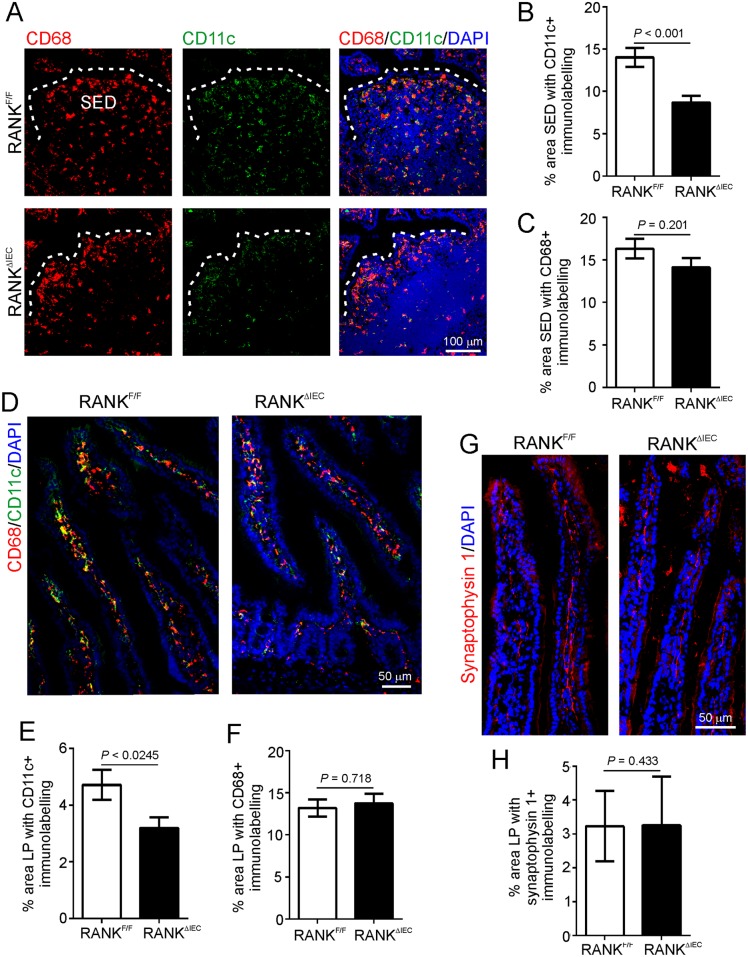
Effect of intestinal epithelial cell-specific RANK-deficiency on mononuclear phagocytes and innervation in the lamina propria.A) Immunohistochemical (IHC) comparison of the distribution of CD11c+ (green) and CD68+ (red) mononuclear phagocytes (indicative of classical DC and tissue macrophages, respectively) in Peyer’s patches from RANKF/F and RANKΔIEC mice. Sections were counterstained with DAPI (blue) to detect cell nuclei. Broken line shows the lumenal boundary of the follicle associated epithelium. SED, subepithelial dome. Morphometric analysis revealed that (B) the % area of the SED occupied by CD11c+ immunostaining was significantly reduced in RANKΔIEC mice (P < 0.001, Mann-Whitney U test), whereas (C) the % area occupied by CD68+ immunostaining was similar between each mouse group (P = 0.201, Student’s t-test; data derived from 1–10 SED/mouse, n = 6–7 mice/group). D) IHC comparison of the distribution of CD11c+ (green) and CD68+ (red) mononuclear phagocytes in the lamina propria (LP) of RANKF/F and RANKΔIEC mice. Sections were counterstained with DAPI (blue). Morphometric analysis revealed that (E) the % area of the CD11c+ immunostaining was also significantly reduced in the LP of RANKΔIEC mice (P < 0.025, Mann-Whitney U test), whereas (F) the % area of CD68+ immunostaining was similar (P = 0.718, Student’s t-test; data derived from 1–6 LP areas/mouse, n = 7 mice/group). G) Sections of intestine from RANKF/F and RANKΔIEC mice were immunostained to identify synaptophysin 1 (red) within synaptic vesicles, enabling the enteric innervation in the gut wall to be compared. Sections were counterstained with DAPI (blue). H) Morphometric analysis revealed that the % area of synaptophysin 1+ immunostaining within the LP of RANKF/F and RANKΔIEC mice was similar (P = 0.433, Mann-Whitney U test; data derived from 2 LP areas/mouse, n = 4 mice/group). These data implied that RANK-deficiency in the gut epithelium did not influence the enteric innervation in the gut wall.